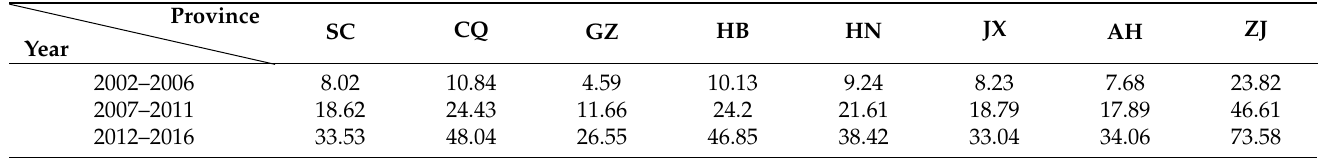
Table 1. Gross Domestic Product (GDP) per capita (10 3 Yuan).